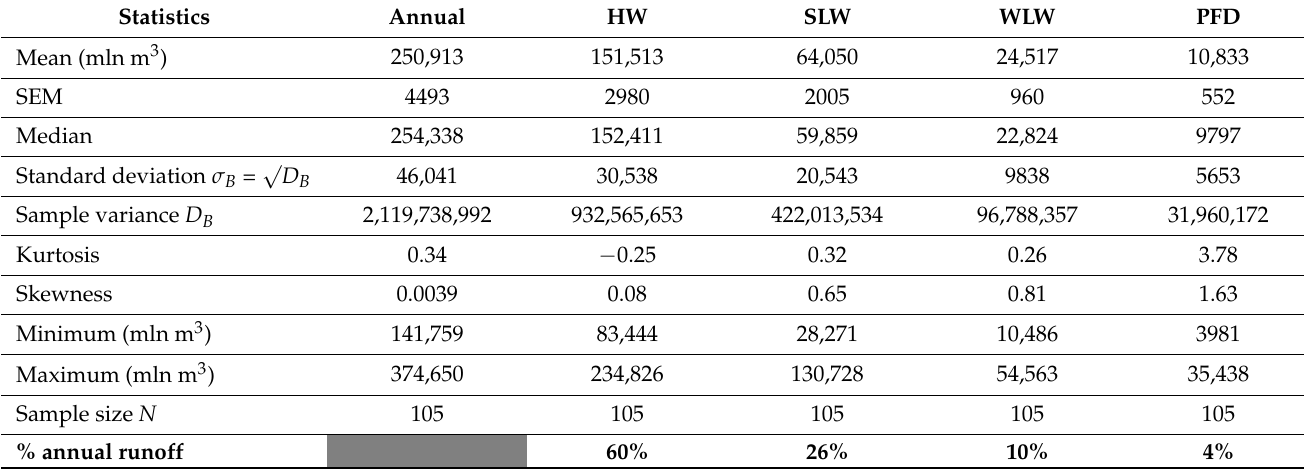
Table 4. Numerical characteristics of the inflow distributions for 1916–2020